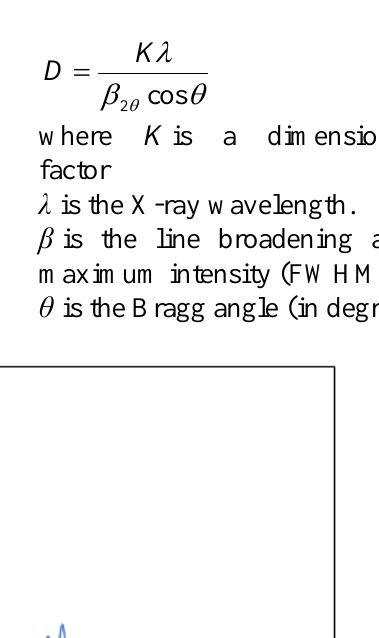
O thin films after heat treatment of the thin films at 2 3